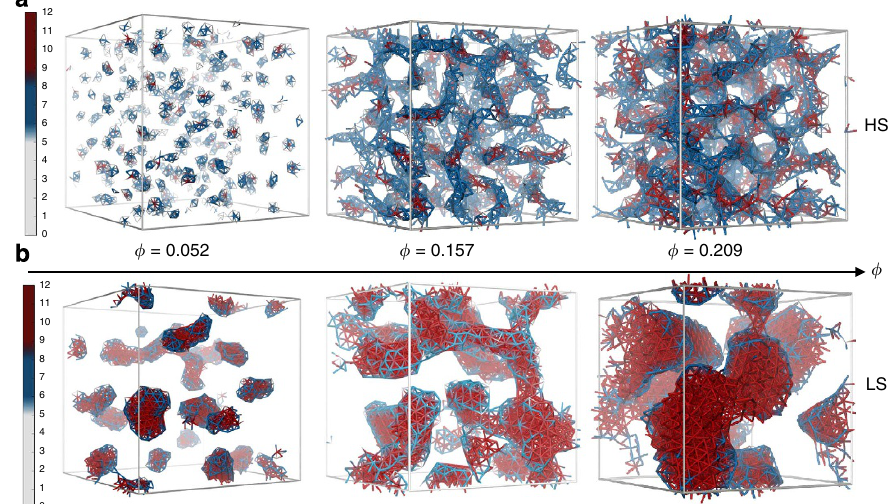
Figure 2 | Simulation snapshots. Snapshots from MD simulations for HS ( a ) and LS ( b ) at different volume fractions f and T ¼ 0.15. We show only bonds between particles and the colour code indicates the coordination number, varying between 0 (light grey) to 12 (dark